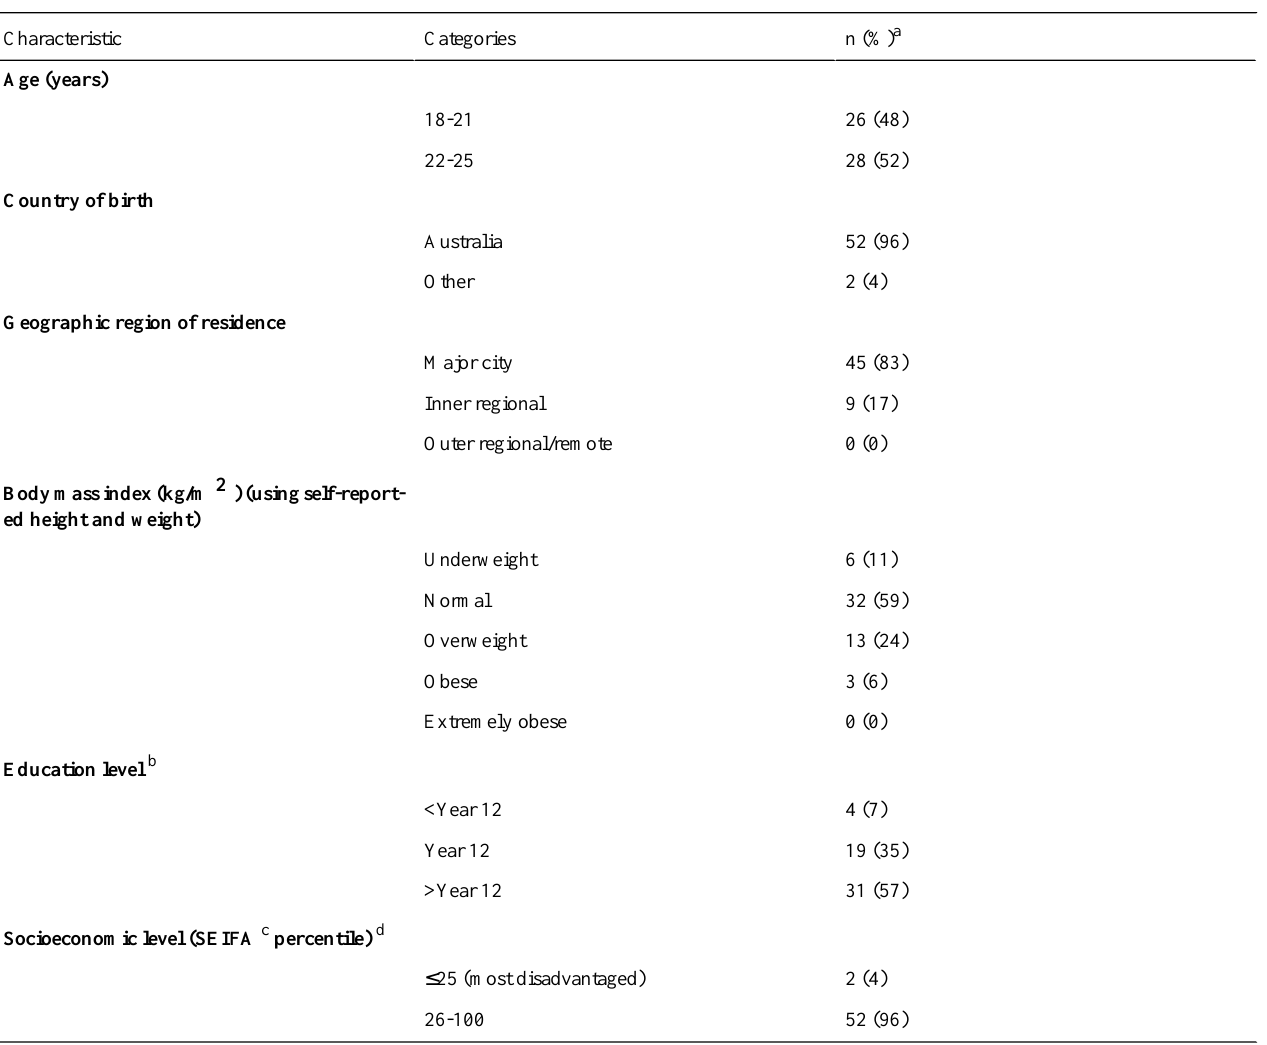
Table 1. Demographic characteristics of participants